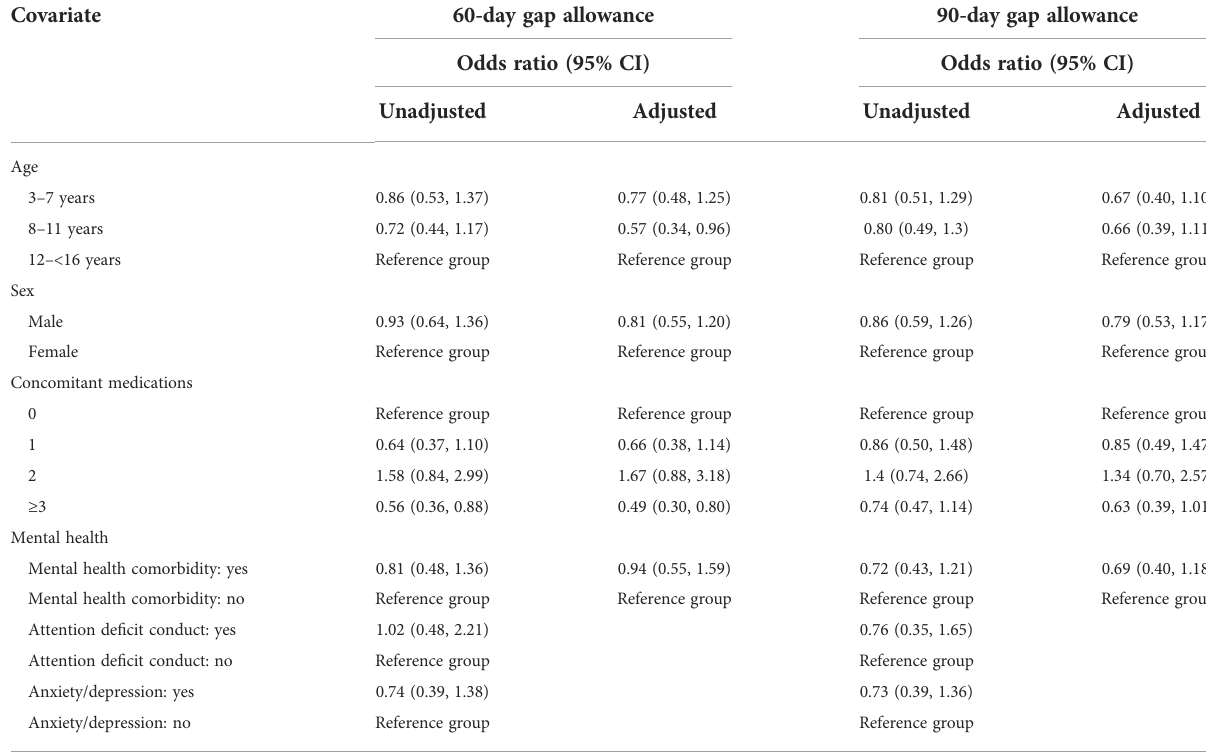
TABLE 3 Cox proportional hazards model, 3+ months of follow-up (cohort A).